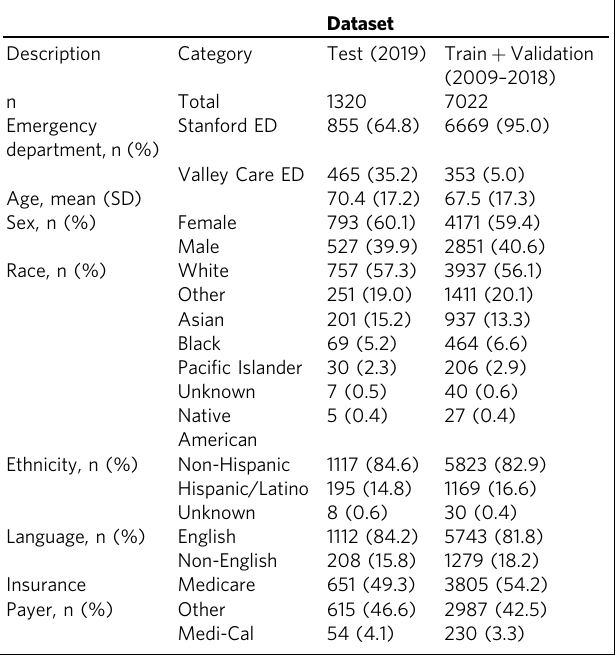
Table 1 Stanford cohort demographics grouped by train test split.